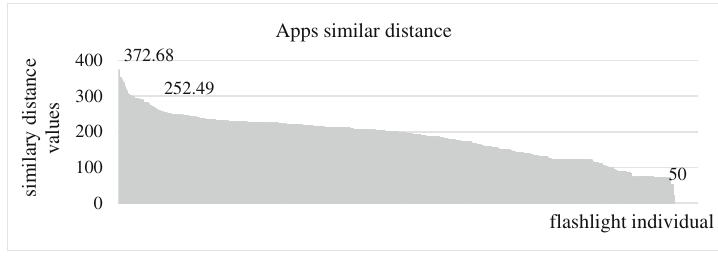
Fig. 3. Apps similar